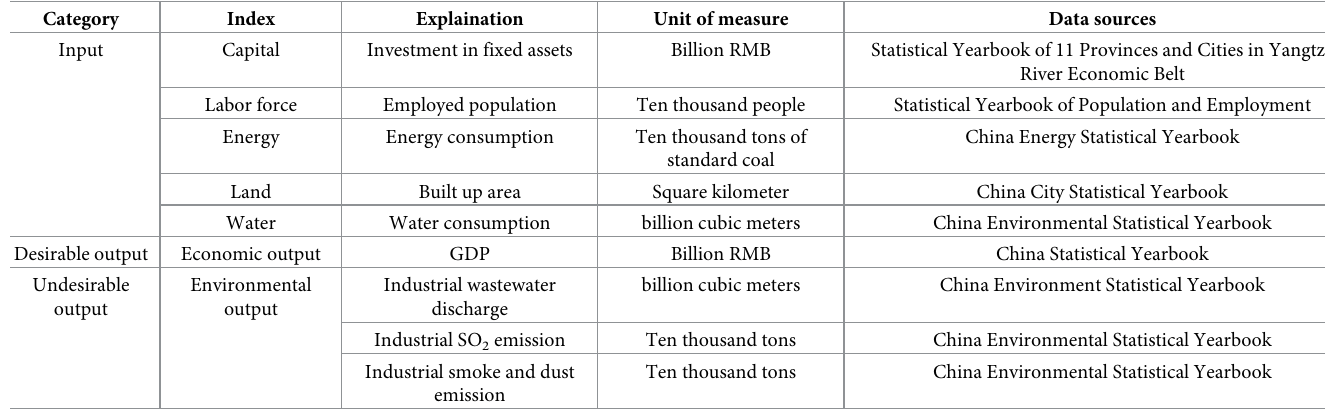
Table 1. Evaluation index of industrial ecological efficiency in Yangtze River Economic Belt.